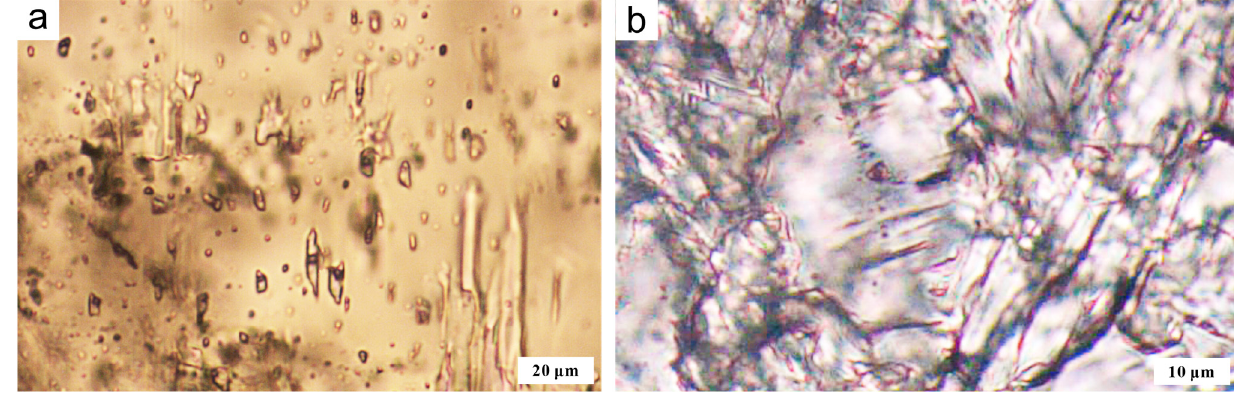
Figure 6 . ( a ) Fluid inclusions in coarser-grained jadeites. ( b ) Fluid inclusions in Type I fi lling jadeite.